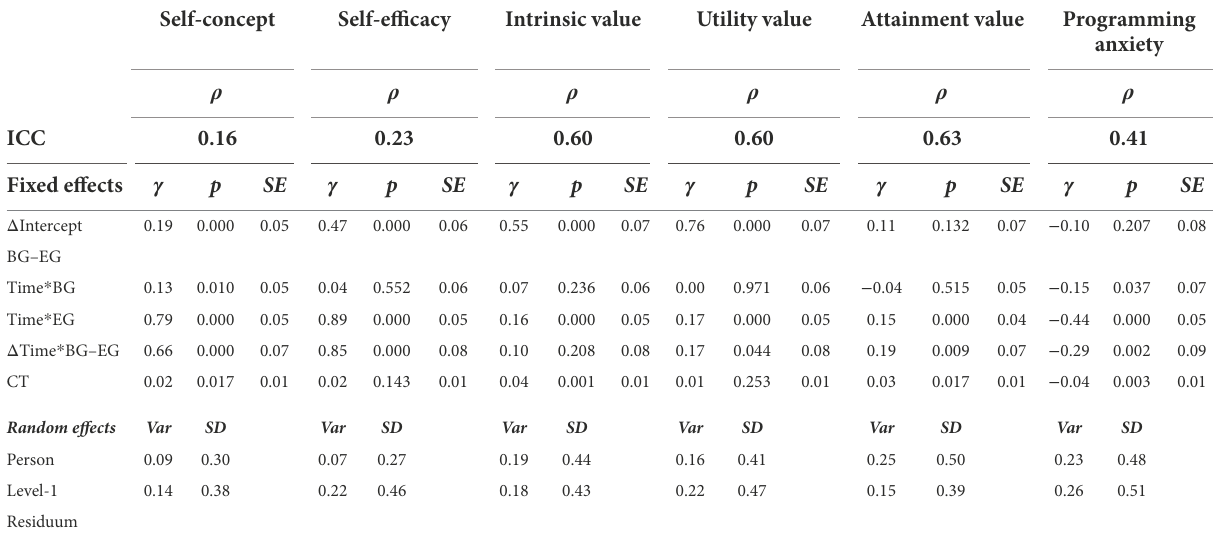
TABLE 4 Mixed level